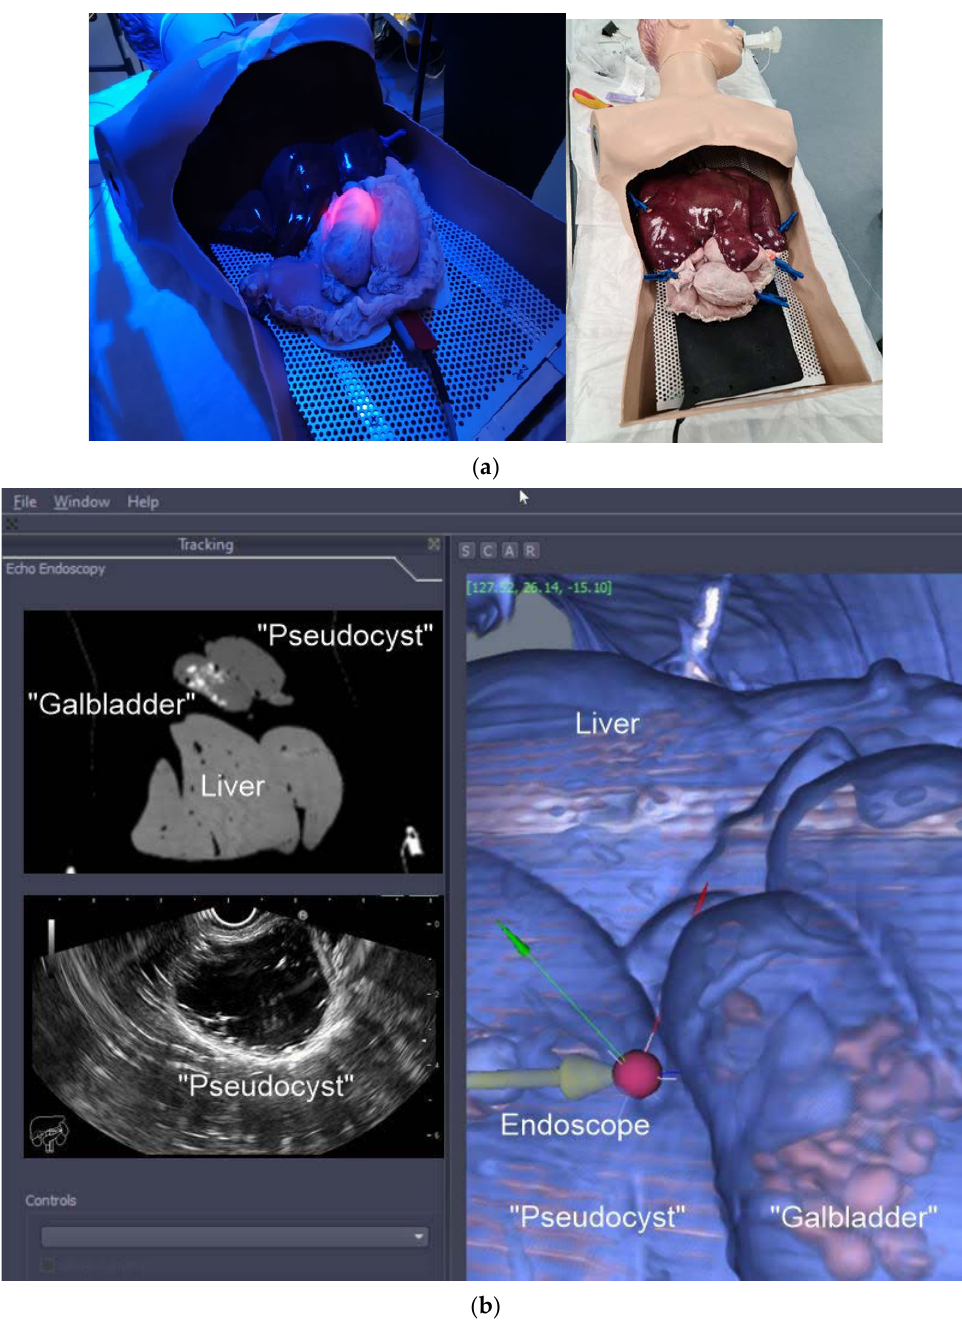
Figure 2. ( a ) Custom-made pig organ model. A custom-made pig organ model was used to test the image fusion software. The design of the model included: overtube; stomach; “pseudocyst”; “gallbladder” (filled with “stones”); liver; ( b ) Image fusion (EUS/CT) testing. EUS–CT fusion in real time showing the 3D reconstruction of the segmented CT with a phantom “gallbladder with stones inside”, “pseudocyst”, and liver (C). The oblique section shows the co-registered large-field CT, showing all 3 organs, and narrow EUS image, showing only the pseudocyst (A and B).